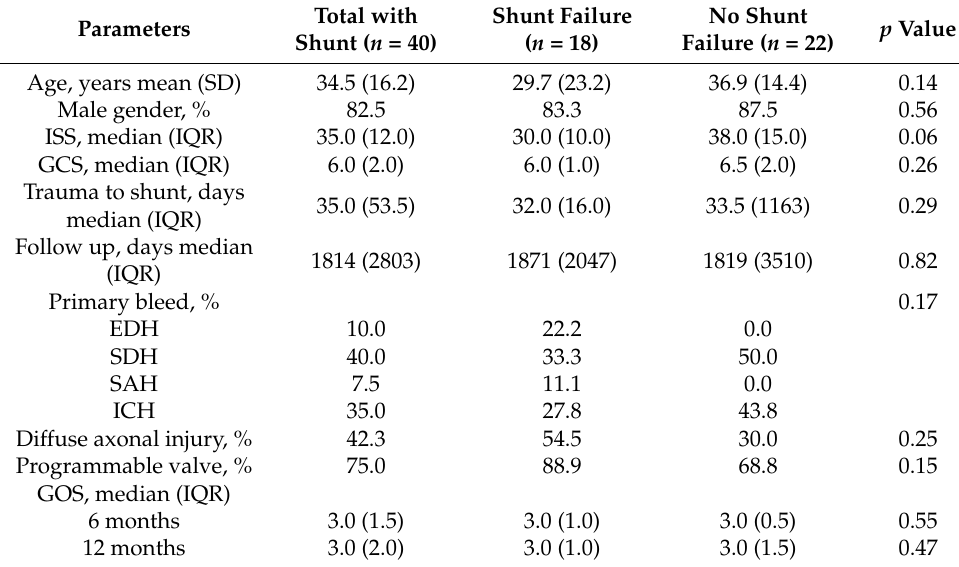
Table 2. Severe TBI patients who developed shunt-dependent hydrocephalus.